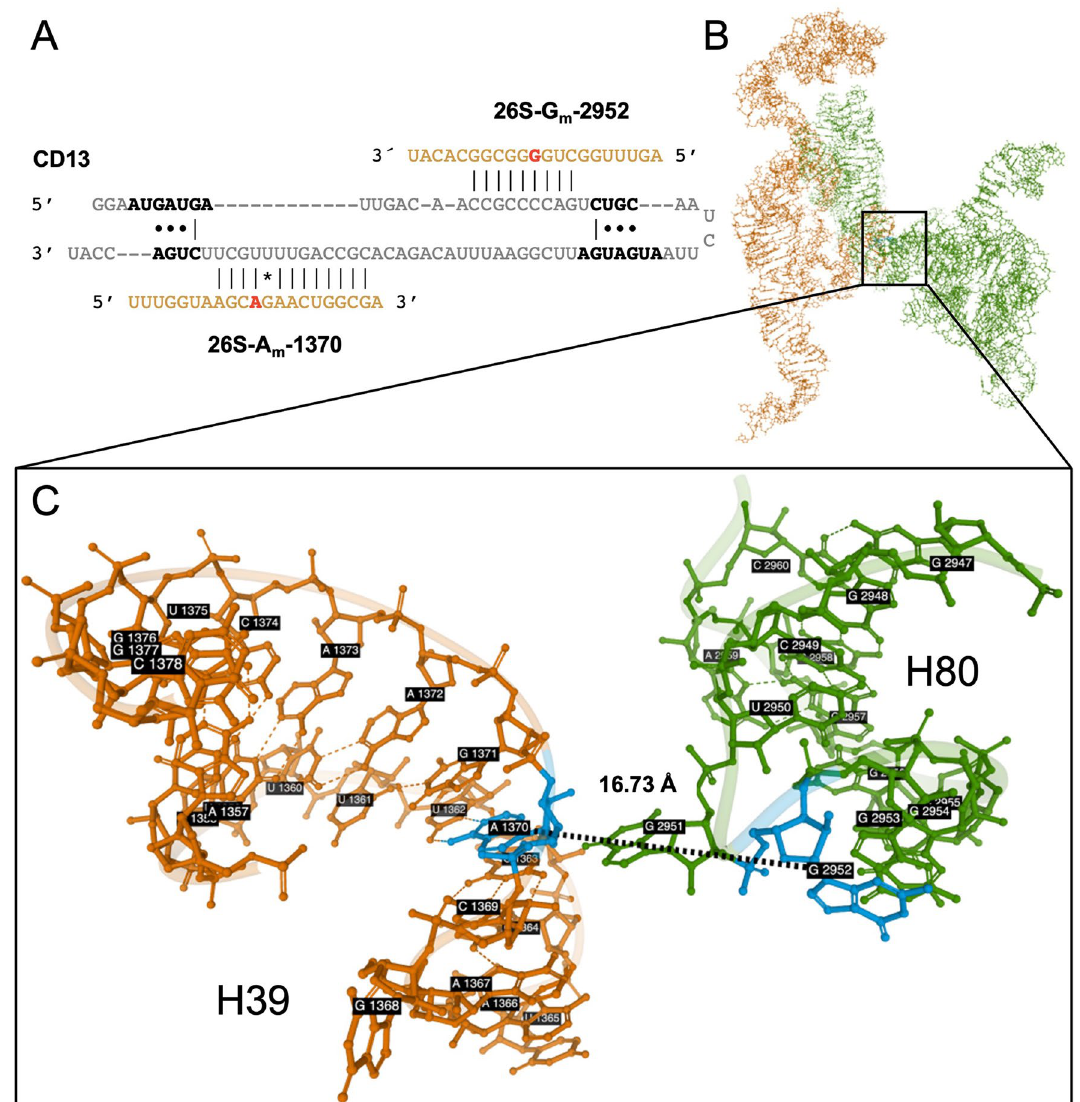
Figure 7. A model on the function of CD13 in guiding 2 ′ - O -Me at two positions in the 26S rRNA. ( A ) Binary secondary structure of CD13 bound to positions A1370 and G2952 in the 26S rRNA of D. discoideum . ( B ) Scheme of relevant structure parts of the nascent 60S ribosomal subunit of D. discoideum (PDB accession: 5AN9) determined at 3.3 Å resolution via cryo-EM 71 . Domain II is displayed in orange and domain V in green (cf. Fig. 4). ( C ) Close vicinity (16.7 Å) of nucleotide A1370 in helix H39 and nucleotide G2952 in helix H80 (both positions colored in in individual interaction pairs. G*U base pairs have been observed also in analogous pairs of other species 12,13 ,